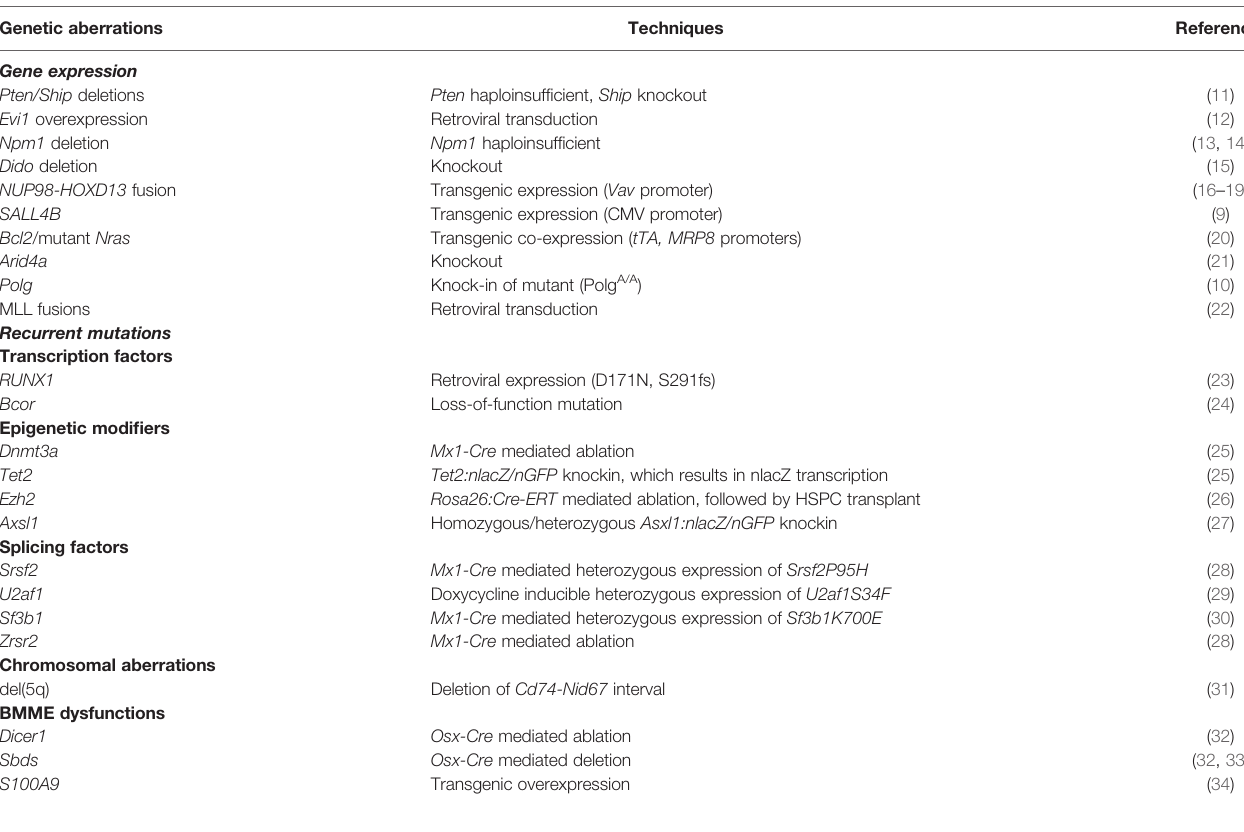
TABLE 1 | Mouse models of